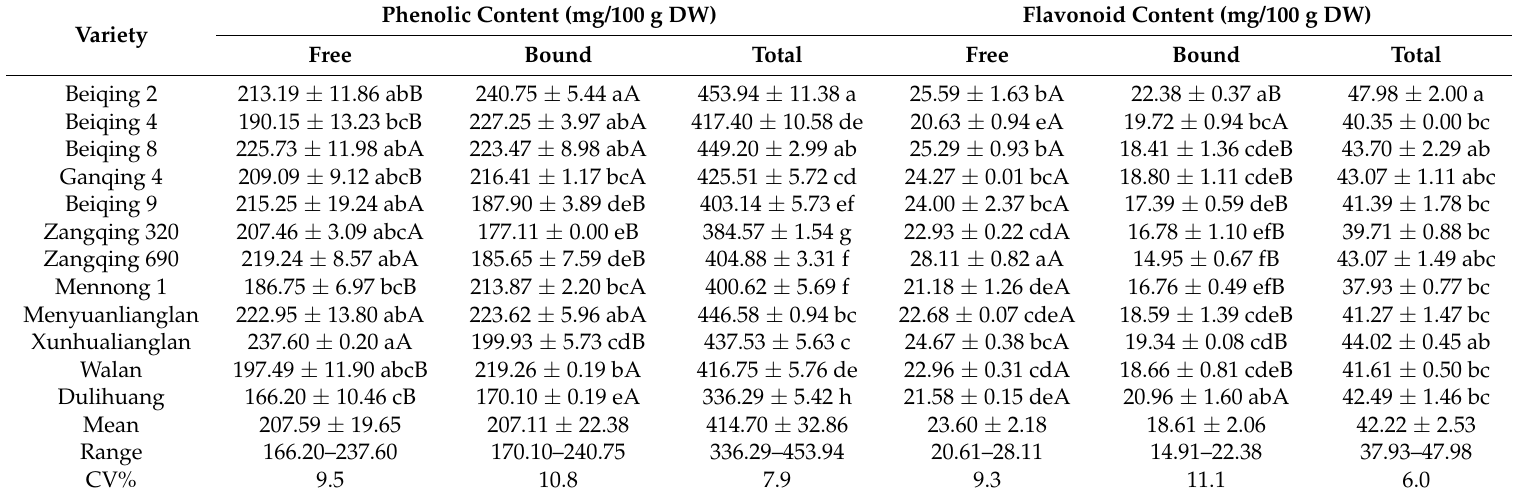
Table 1. Phenolic and flavonoid contents of blue Highland